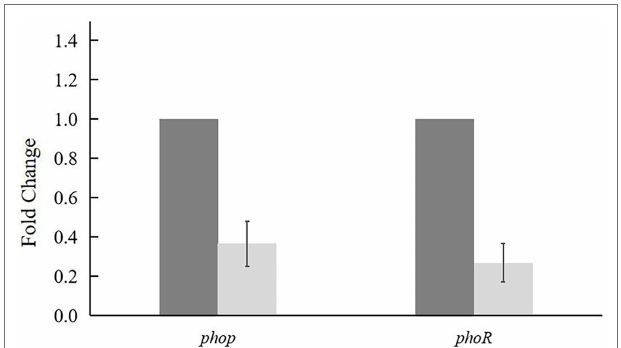
FIGURE 6 | Transcriptional analysis of phop and phoR in X47 strain was analyzed by real-time PCR. X47 strain was cultured on ISP2 with 0 mM (dark gray bars) and 5 mM (light gray bars) K 2 HPO 4 for 72 h. Expression of major sigma factor gene hrdB was used as an internal control. Results are the means of triplet